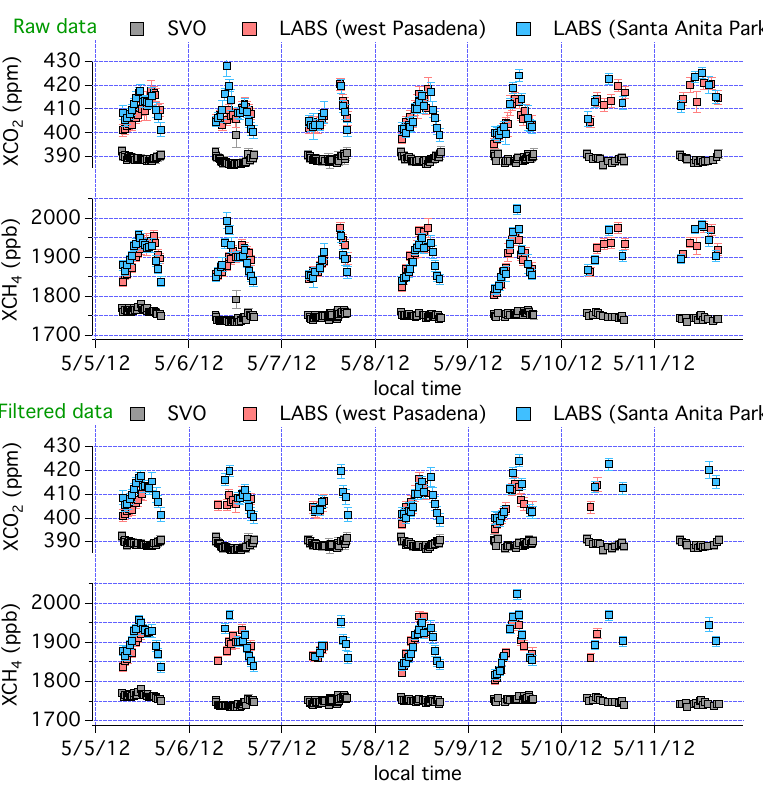
Figure 3. Upper panel shows the raw data, and bottom panel shows the filtered data. Diurnal variations of SVO (grey) and LABS, west Pasadena (red) and Santa Anita Park (blue), and XCO 2 and XCH 4 from around 8:30 to 16:30 on 7 consecutive days in May 2012. Error bars represent the rms of the retrieval spectral fitting residual. Bad data points, such as data taken in the cloudy morning of 11 May, were removed from the filtered data set. From 5 to 9 May the FTS was operated in the target mode, taking alternate measurements between SVO, west Pasadena and Santa Anita Park. On 10 and 11 May the standard measurement cycle was performed, resulting in fewer measurements from each